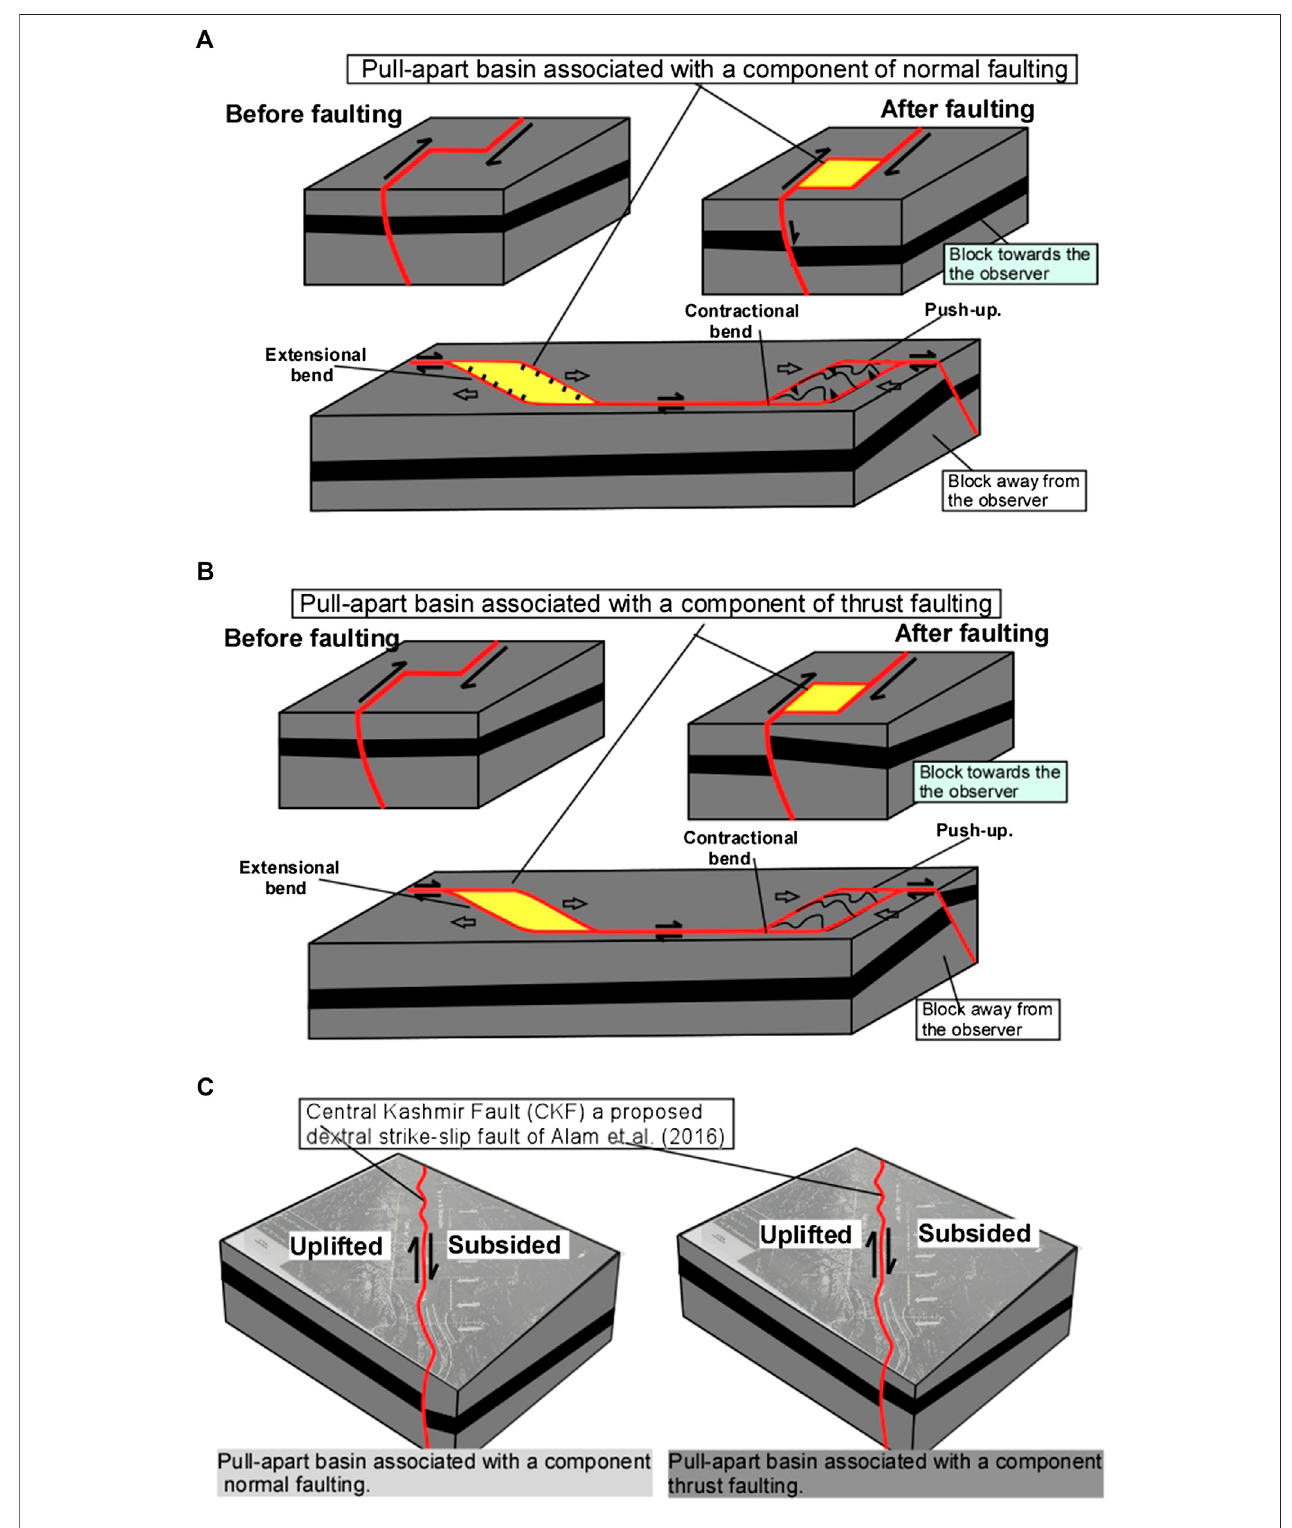
FIGURE11| Aseriesofcartoonsareshowntodemonstratethemajorstructuresthatareusuallyassociatedwithatypicalobliquestrike-slipfaultsystem.Strike-slip withanormal (A) orthrust (B) componentsarerelated tothedrownedandupliftedtopography (C) oftheKashmirbasin(Shah, 2013)and whattypeoffaultslipcouldbe expected on the Central Kashmir fault (CKF), if it exists. Only a strike-slip fault with a normal component can make the present topography of the Kashmir basin.